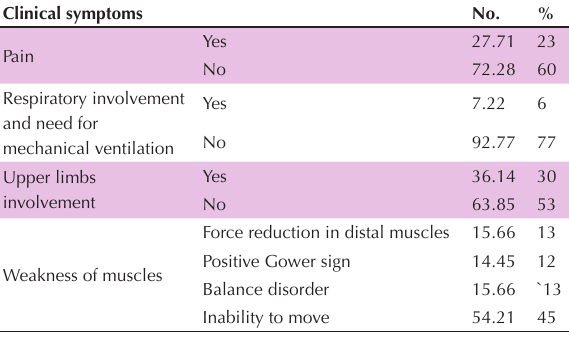
Table 4. Frequency distribution of clinical symptoms of the studied patients Clinical symptoms No.